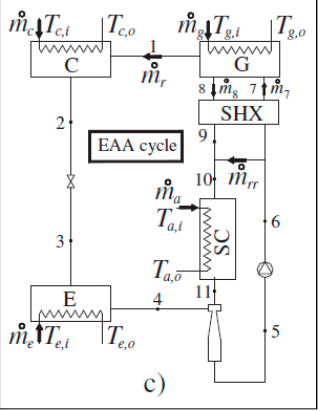
Figure 17. Ejector-enhanced absorption system [186].